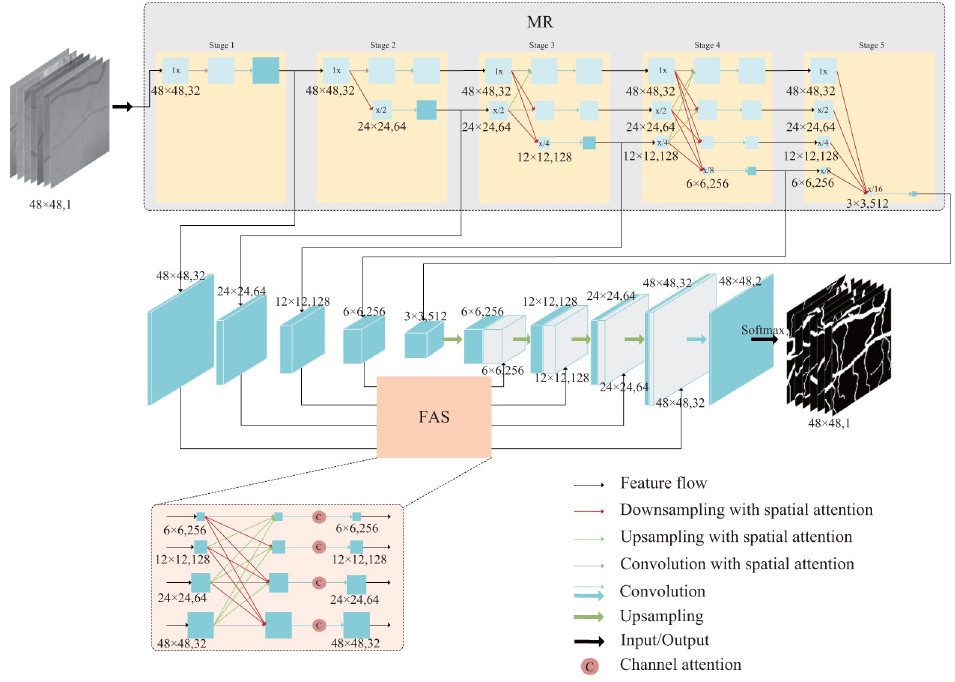
Fig 1. Overview of MFI-Net segmentation model for retinal